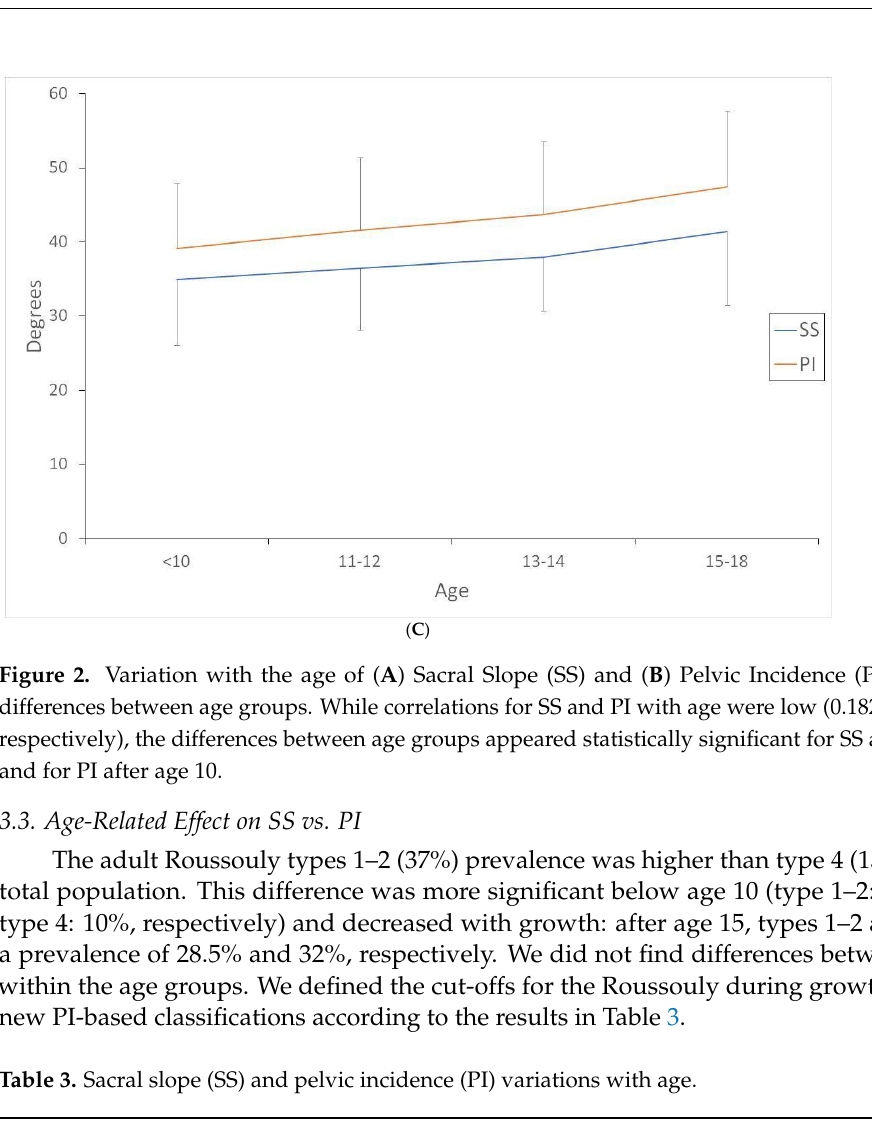
Table 3. Sacral slope (SS) and pelvic incidence (PI) variations with age.